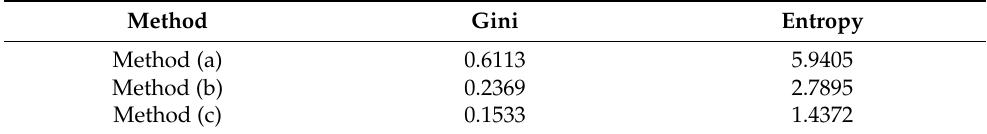
Table 4. Gini coefficients and entropy for the three decision trees